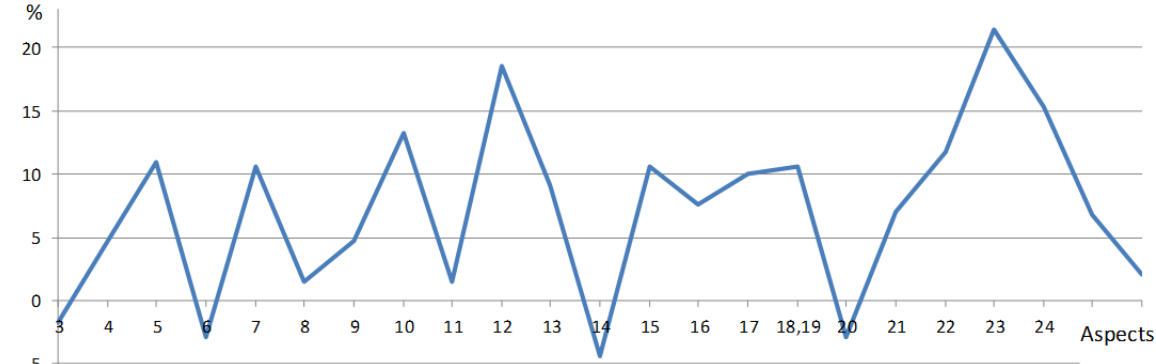
Figure 6. Difference „%ICT-EOIs – %non-ICT-EOIs dependence on aspects 3 – 26 at v100% i-security performance.